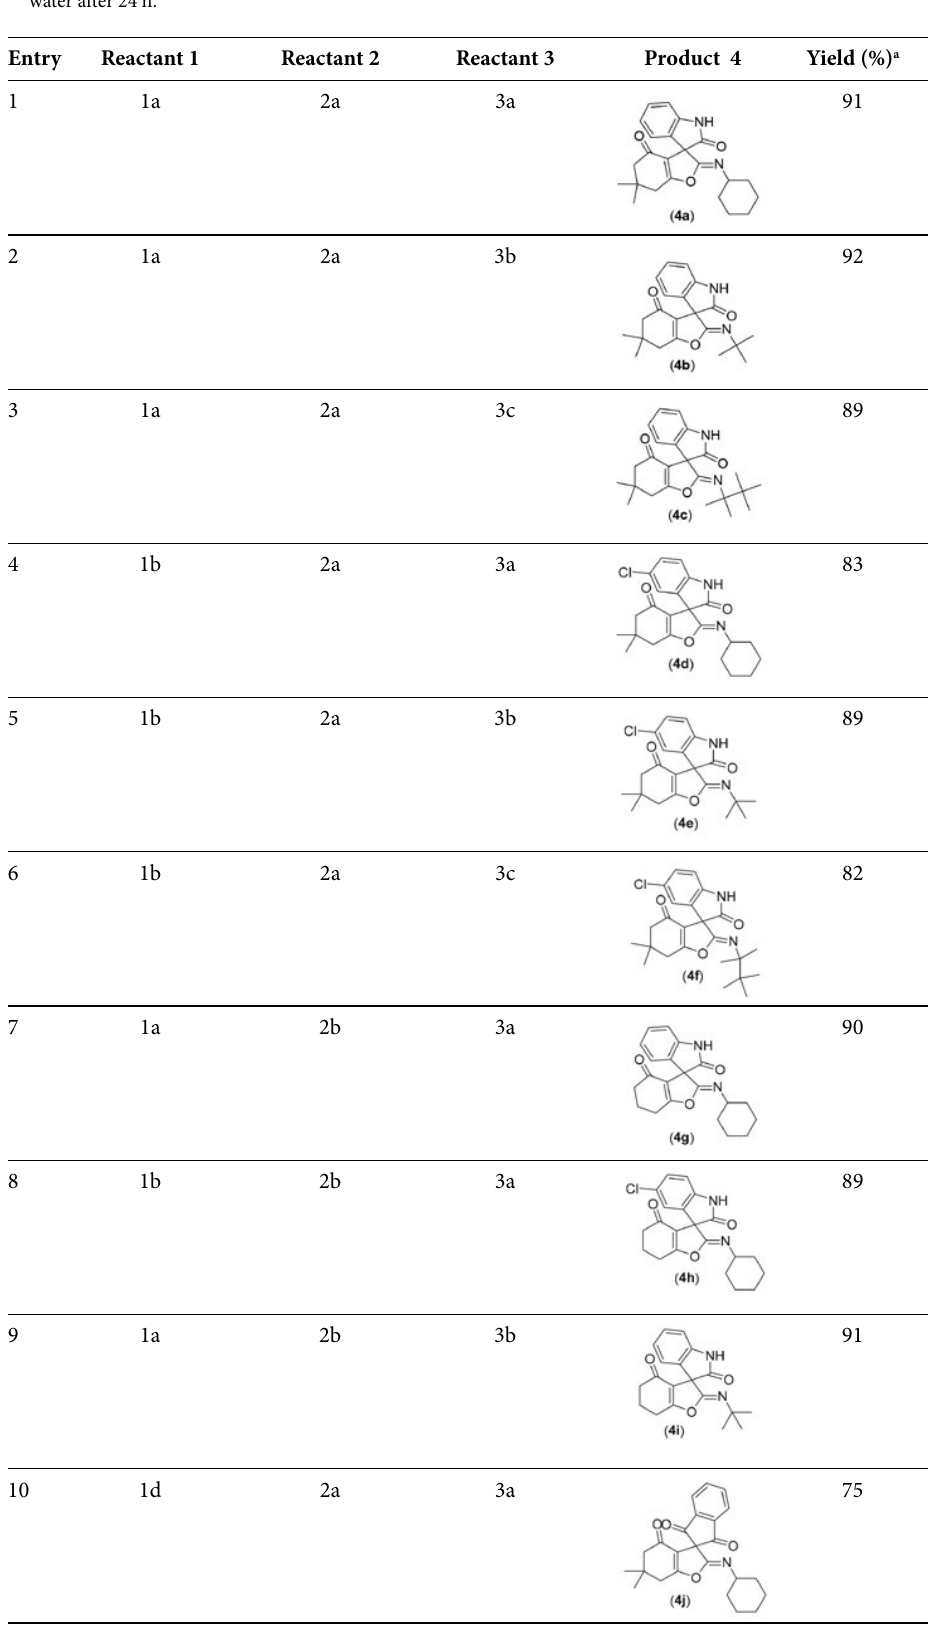
Table 3. The one-pot multi-component synthesis of γ-spiroiminolactone derivatives in the presence of SDS in water after 24